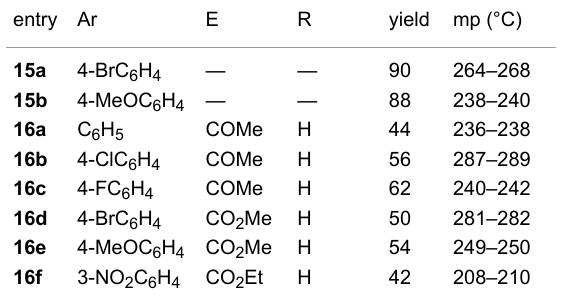
Table 3: The bromides 15a,b and the new 7-pyrimidinylindolizines 16a – f